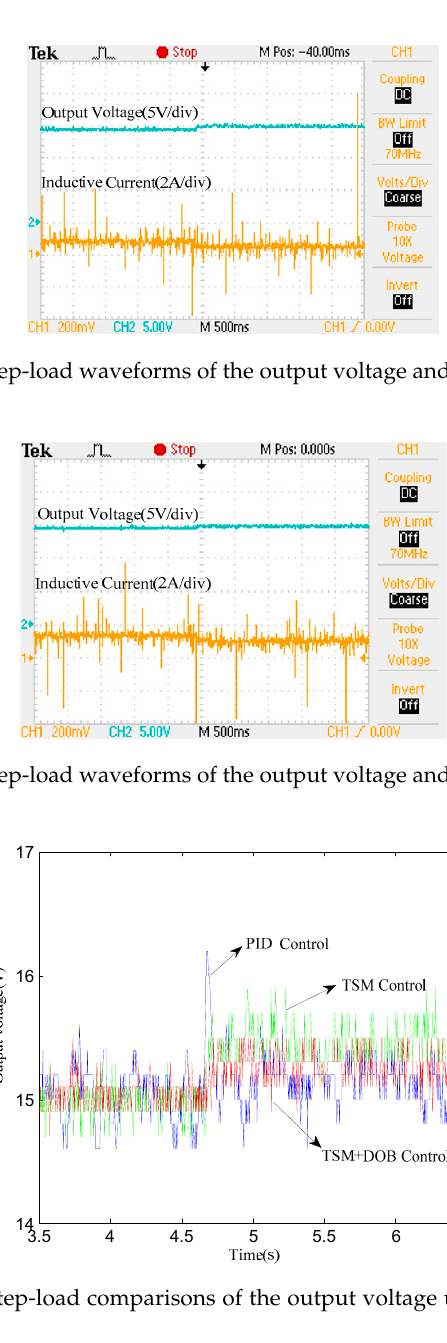
Figure 15. Experimental step ‐ load waveforms of the output voltage and inductive current under the PID controller.